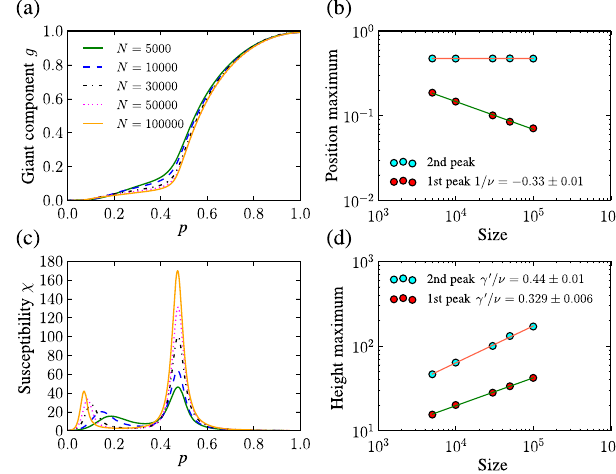
FIG. 2. Bond percolation simulations for networks with a FIG. 1. Bond percolation simulations for networks of N ¼ 5 × 10 4 nodes with a power-law degree distribution, γ ¼ 3 . 1 , and power-law degree distribution with γ ¼ 3 . 1 , target clustering spectrum ¯ c ð k Þ ¼ 0 . 25 , and different network sizes. (a) Relative different levels of clustering. (a) Relative size of the largest size of the largest connected component as a function of the bond connected component g as a function of the bond occupation occupation probability p . (c) Susceptibility χ as a function of the probability p . (b) Degree-dependent clustering coefficient ¯ c ð k Þ . bond occupation probability p . (b, d) Position p and height (c) Susceptibility χ as a function of the bond occupation max χ of the two peaks of χ as functions of the network size N . The probability p . (d) Percolation threshold ( p ) as a function of max max straight lines are power-law fits, and (b) and (d) show the the level of clustering. measured values of the critical